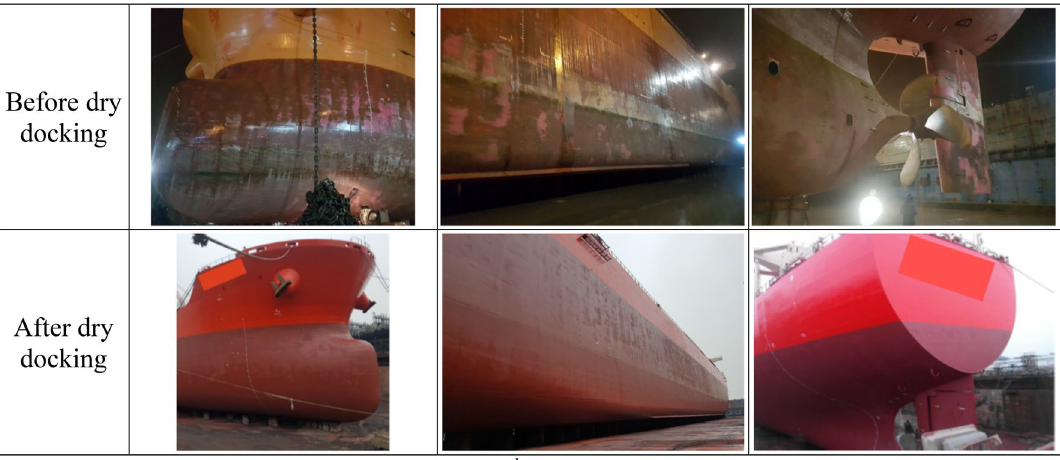
Figure 3. Photographs of the 2nd dry docking (December